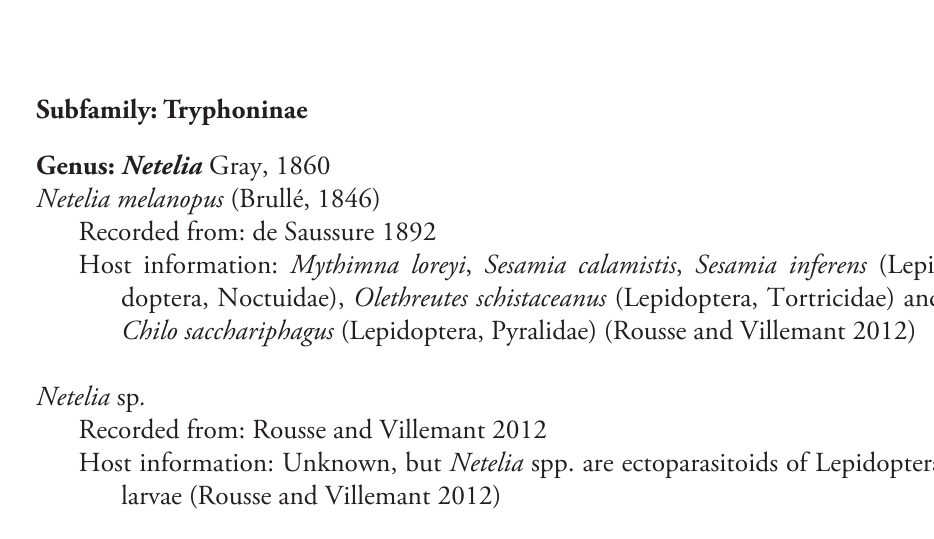
Table 1. List of Ichneumonoidea recorded from Reunion Island. Familly Subfamilly Genus / Species